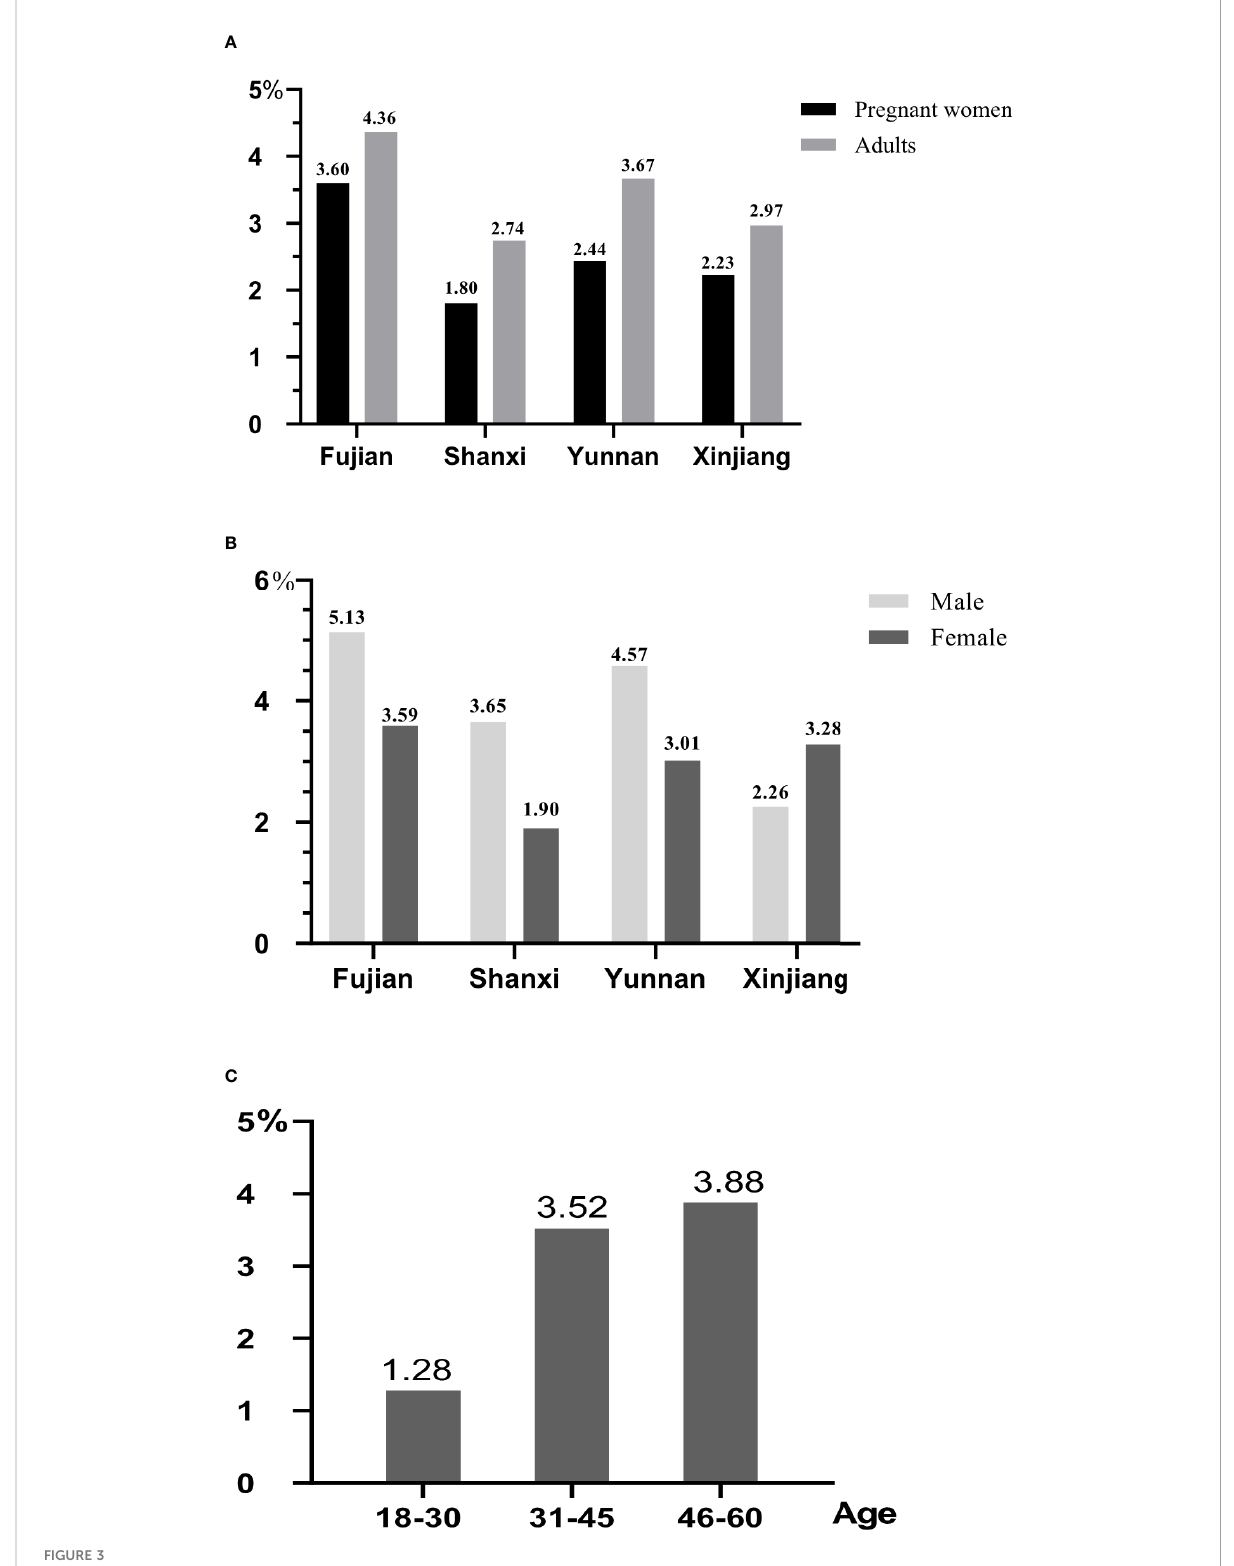
FIGURE 3 The historyof thyroiddiseasesfordifferent populations. All datawere presentedaspercentage. (A) Thecomparisonof history of thyroid diseases betweenadults and pregnant women. (B) Thecomparisonof history of thyroid diseasesbetweenmale andfemale. (C) The comparison of history of thyroiddiseases foradultsin